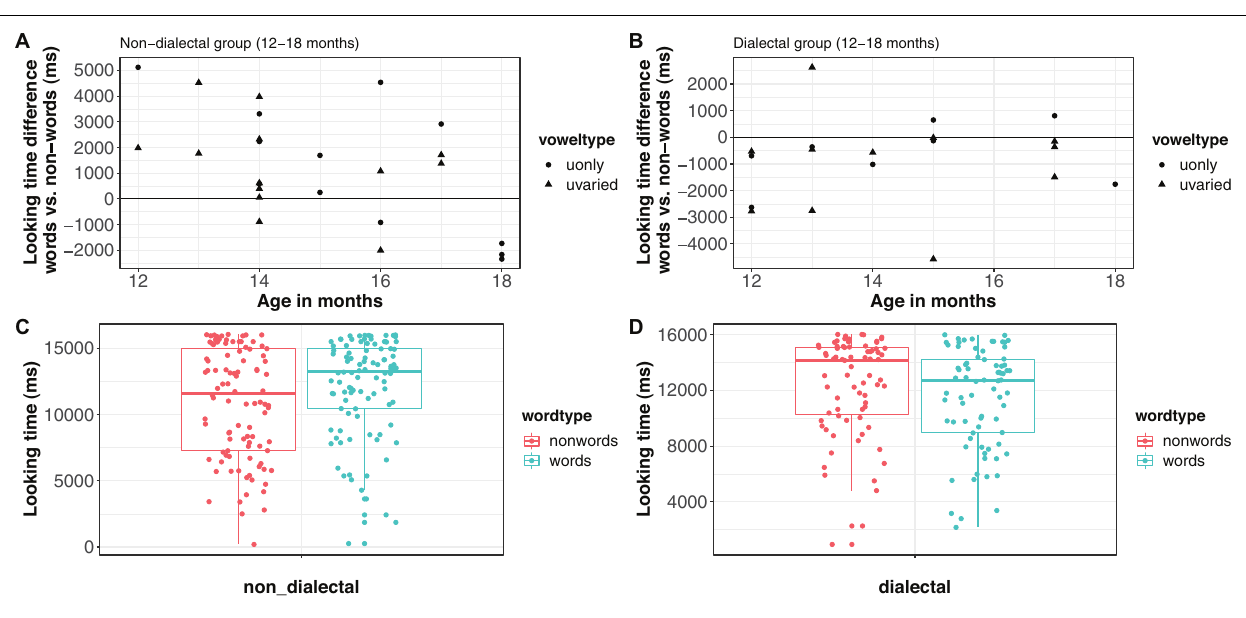
the younger children. Separate analyses by block showed longer looking times to words than nonce-words in block 1 [ F ( 1 , 72 ) = 3, p = 0.08] and an interaction between word-type and age in block 2 [ F ( 1 , 73 ) = 20.2, p < 0.0001], see Figure 4 , left